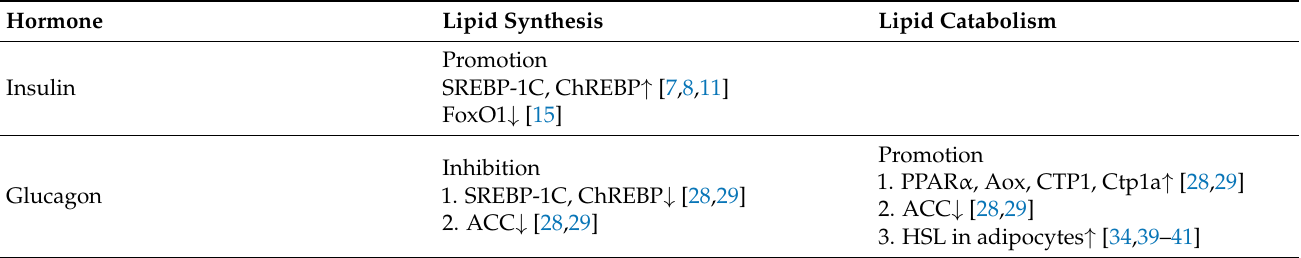
Table 1. Summary of hormones and their effects on lipid production and